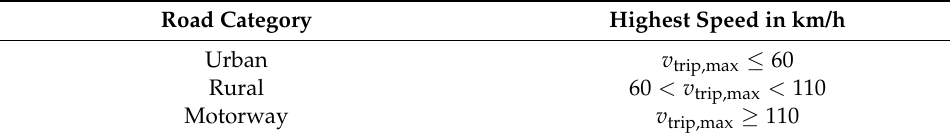
Table 2. Classification of road categories according to the highest